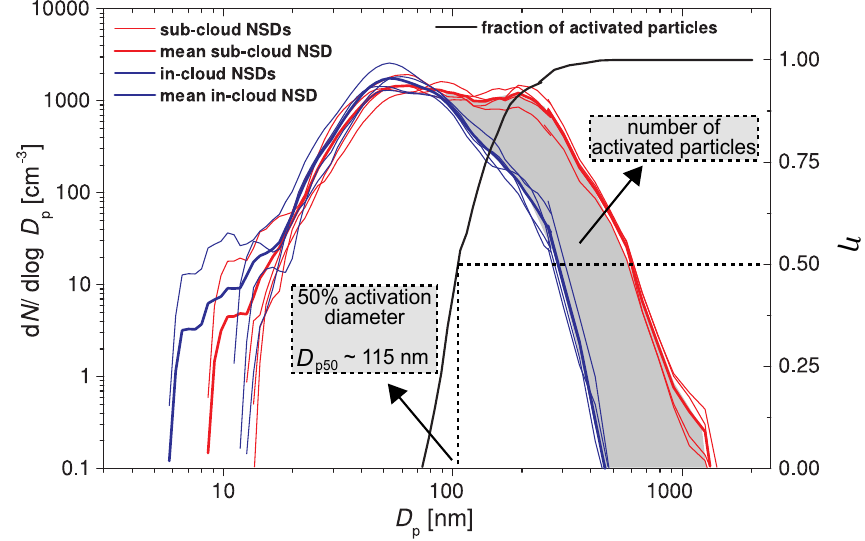
Fig. 6. Aerosol number size distributions of the interstitial aerosol (left ordinate) inside (blue lines) and below (red lines) the observed stratocumulus layer and number fraction of activated particles (right